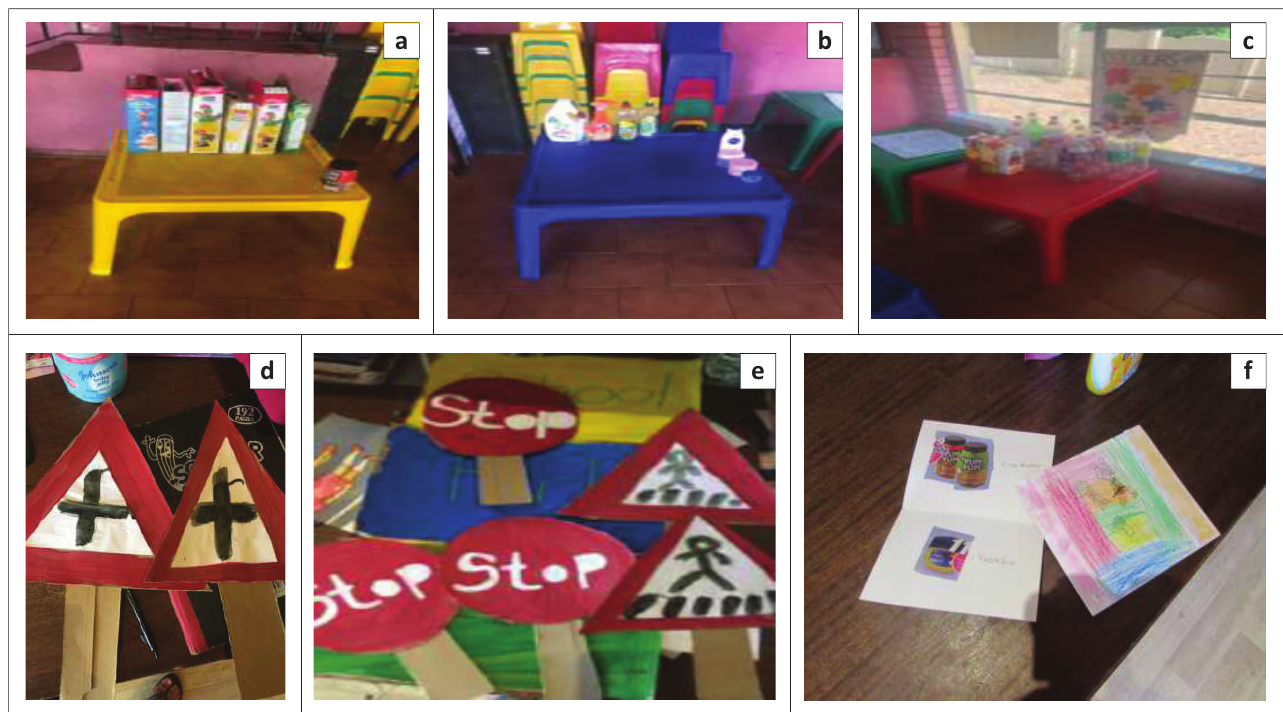
FIGURE 4: Photos of environmental print materials and recycled (‘new’) materials: (a), (b), and (c) are examples of the materials collected; (d), (e) and (f) are examples of how the materials were